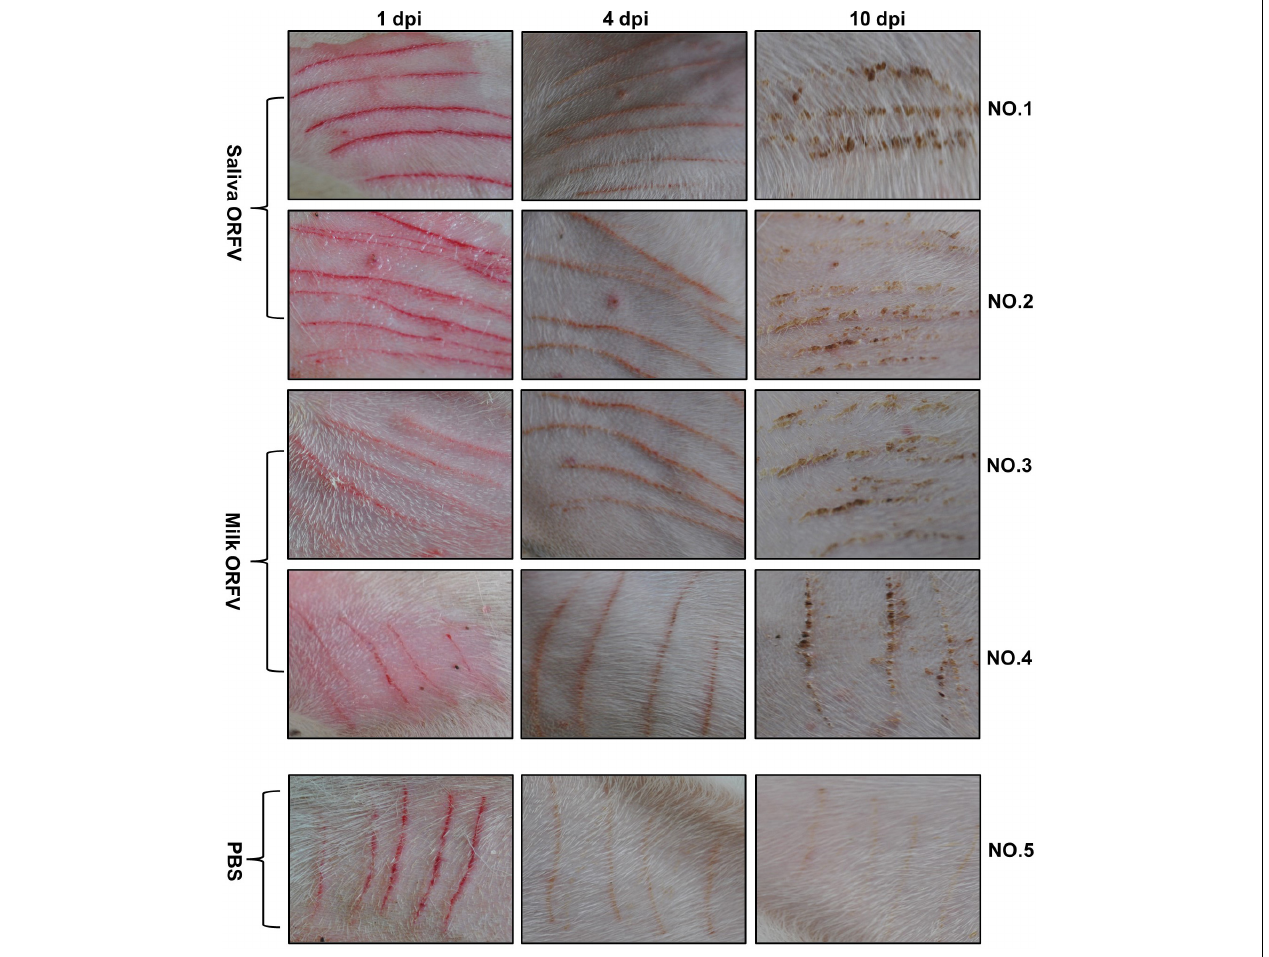
FIGURE 3 | Experimental infection of dairy goats using saliva- and milk-isolated ORFV. ORFV-free dairy goats (NO. 1–5) were scratched with sterile syringe needles in the inner thighs and inoculated with saliva ORFV (Saliva ORFV), milk ORFV (Milk ORFV), or MEM (Medium). The scratch lesions were monitored daily for 10 days. The results are shown for 1 day (1 dpi), 4 days (4 dpi), and 10 days (10 dpi) post